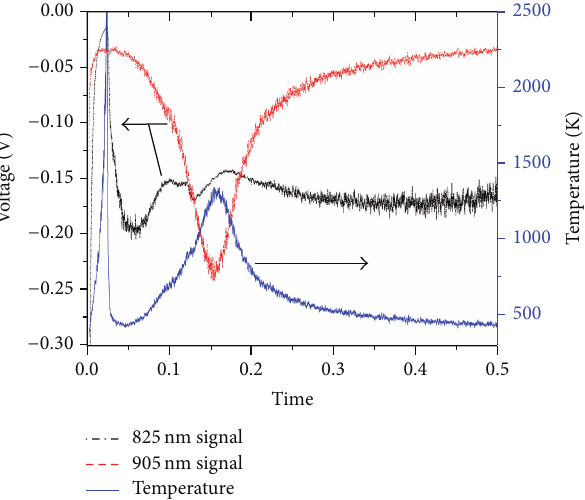
Figure 10: Representative filtered signals and calculated tempera- ture for the PMT pyrometer.